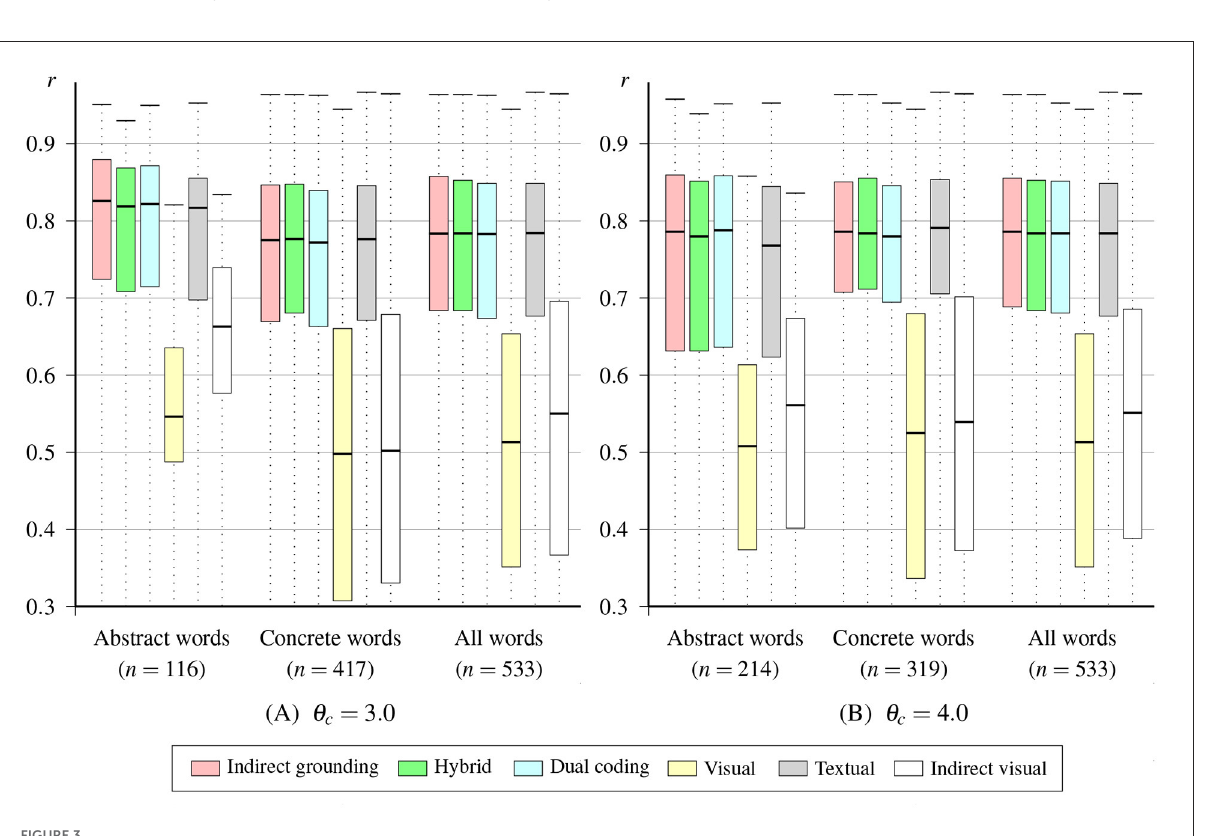
Table2. It is therefore concluded that the indirect grounding view is plausible as a conceptual representation theory